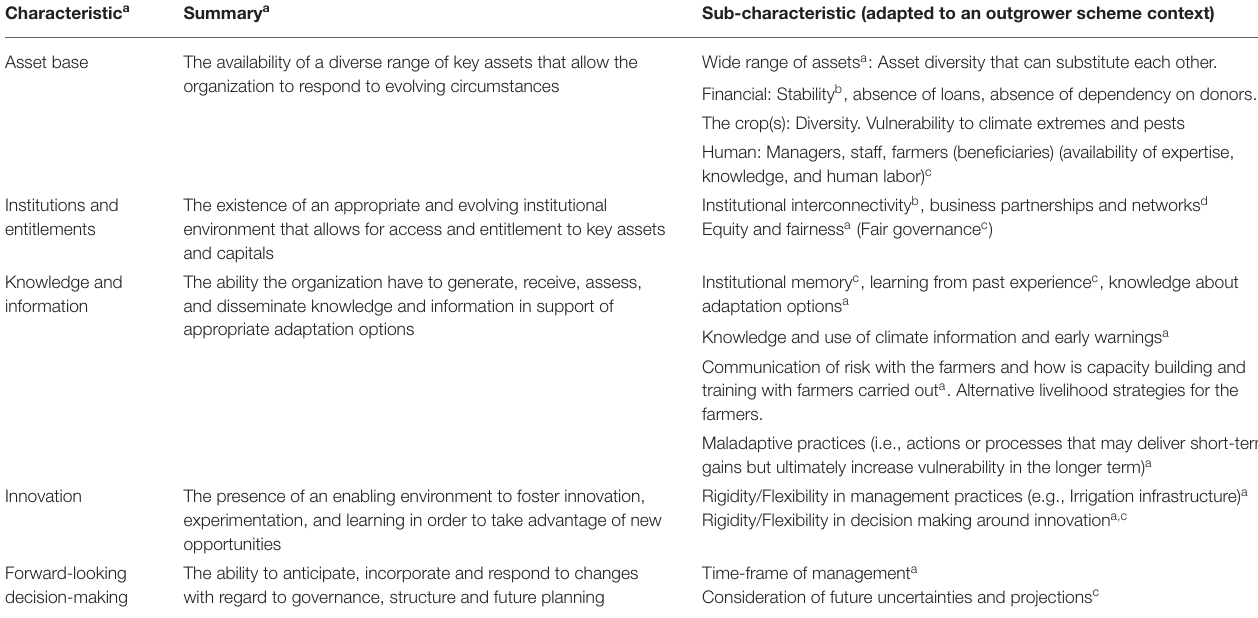
TABLE 1 | Our adaptive capacity framework, adapted from Jones et al. (2017) to correspond to the context and scale of the management level of sugarcane outgrower schemes. Characteristic a Summary